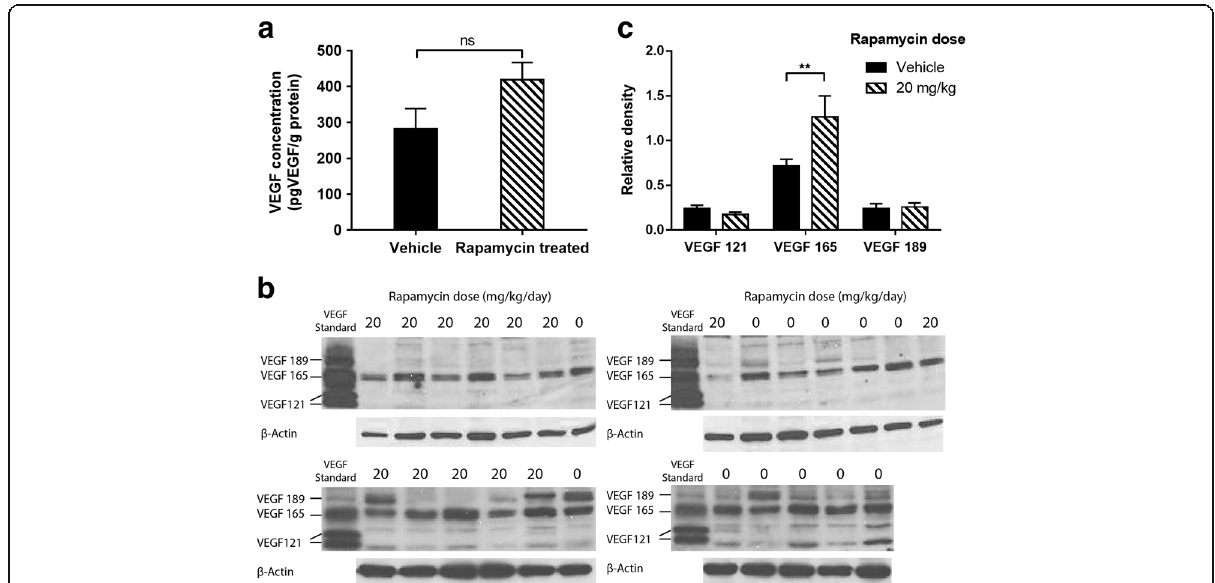
Fig. 6 The effect of rapamycin therapy on VEGF levels in FaDu xenografts. a Changes in VEGF levels as measured by ELISA. Differences in levels were not statistically significant. b Changes in VEGF isoforms assessed by Western blot in FaDu xenografts treated with either rapamycin (20 mg/ kg/day) or vehicle control for 10 days. c Changes in VEGF isoforms were measured using densitometry in the corresponding blots. Data are presented as mean ± SEM, ** P < 0.01, n =